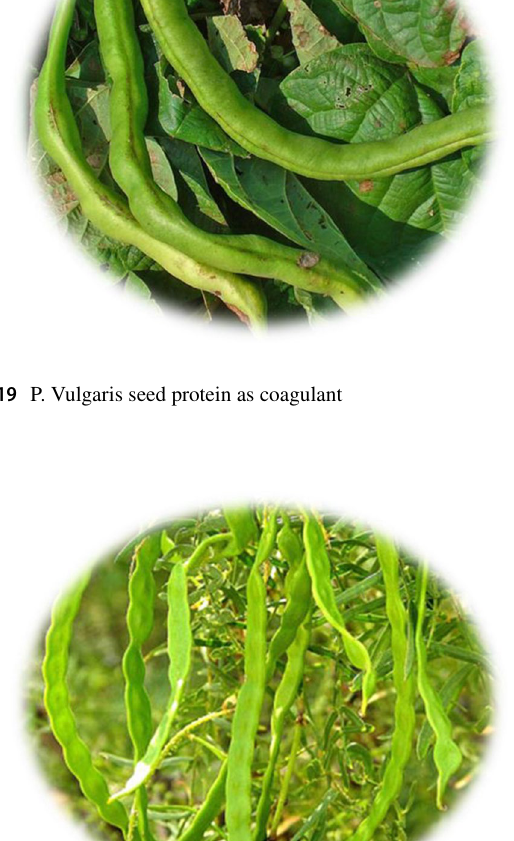
Fig. 18 Parkinsonia aculeate seeds as coagulants